Question: Summarize what this figure shows in one sentence.
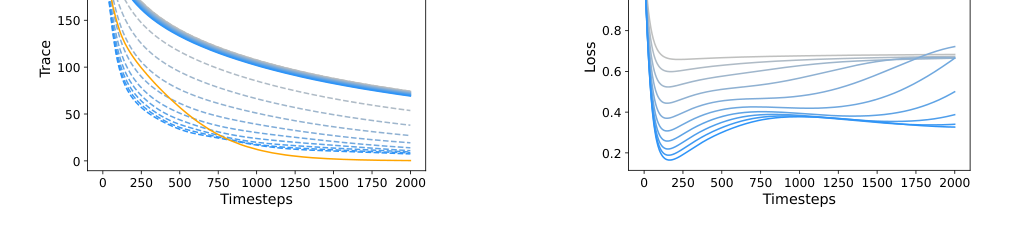
Answer: We train linear models on our toy model using 1-SAM. Bluer curves denote larger ρ. We randomly initialize the model, although we observe similar curves when initialized at the origin.